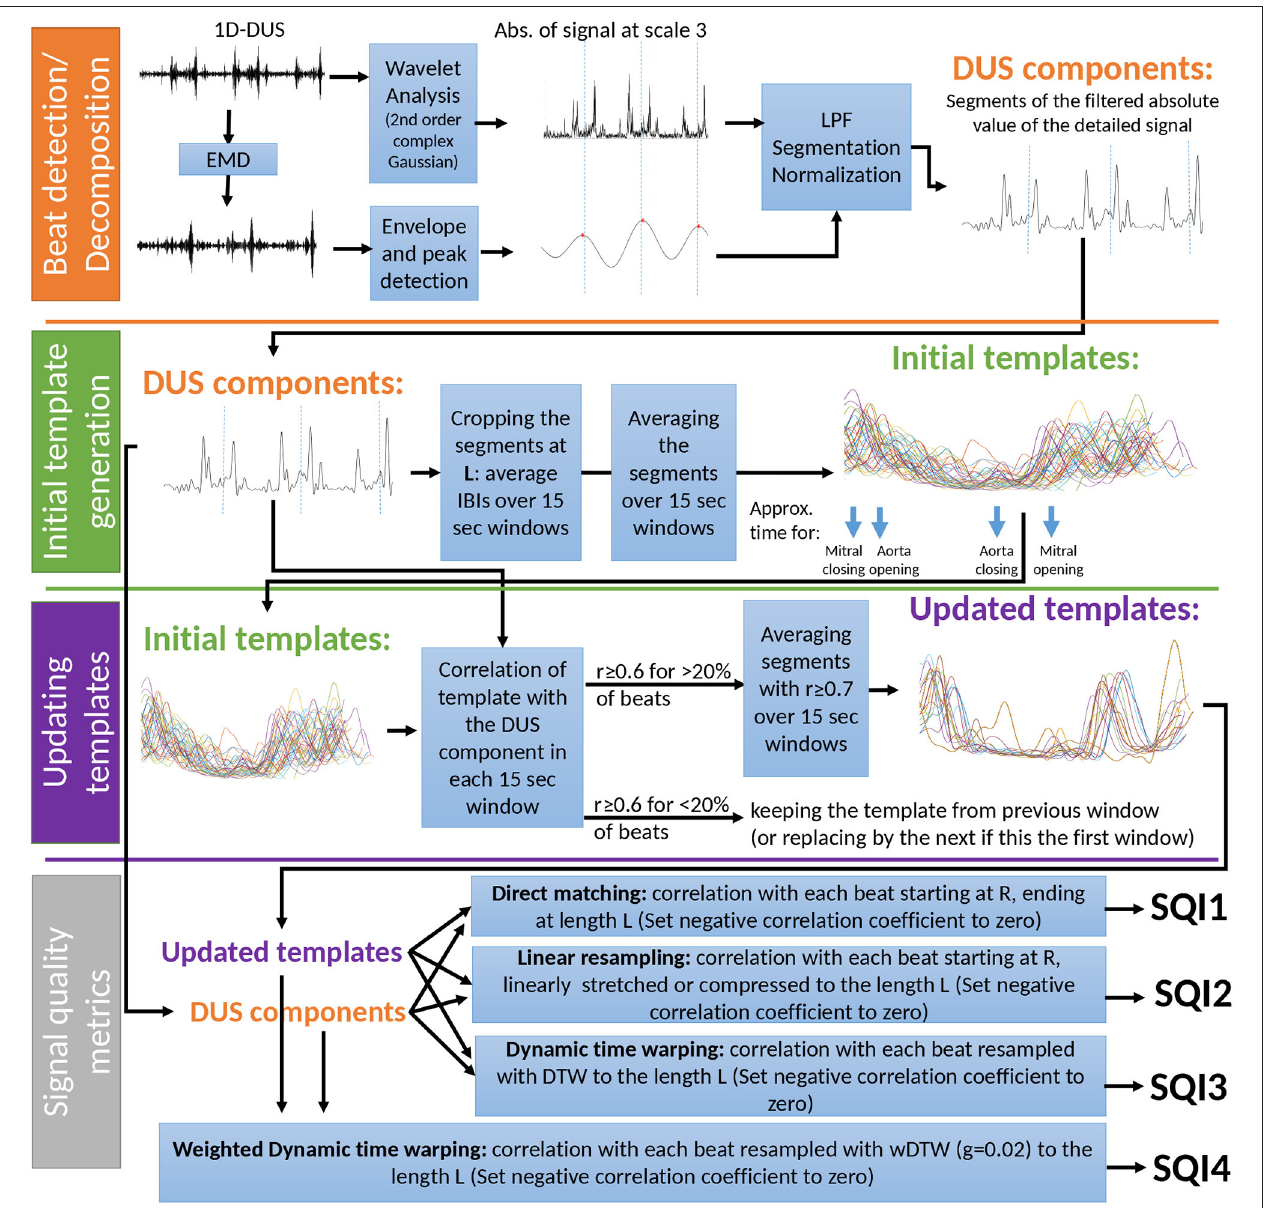
FIGURE 3 | Overview of the template-based quality method for the Doppler signal.